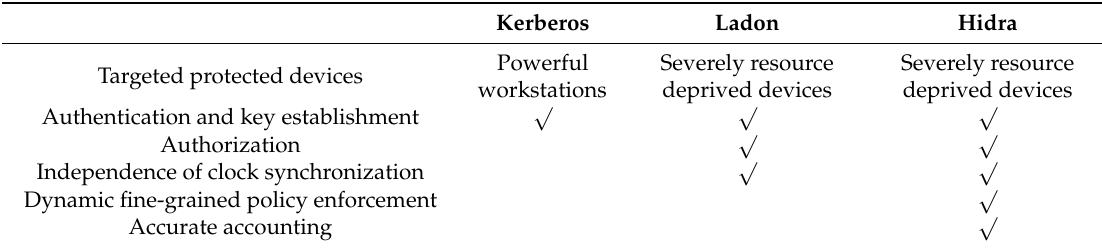
Table 1. Comparison among Hidra, Ladon and